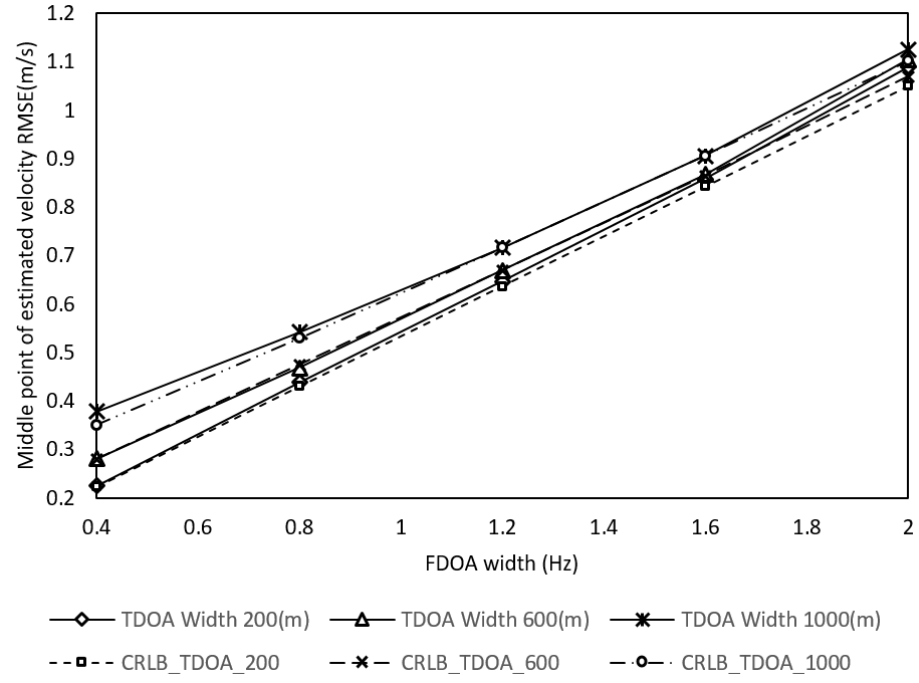
Figure 7. The influence of TDOA and FDOA errors on the RMSE of velocity